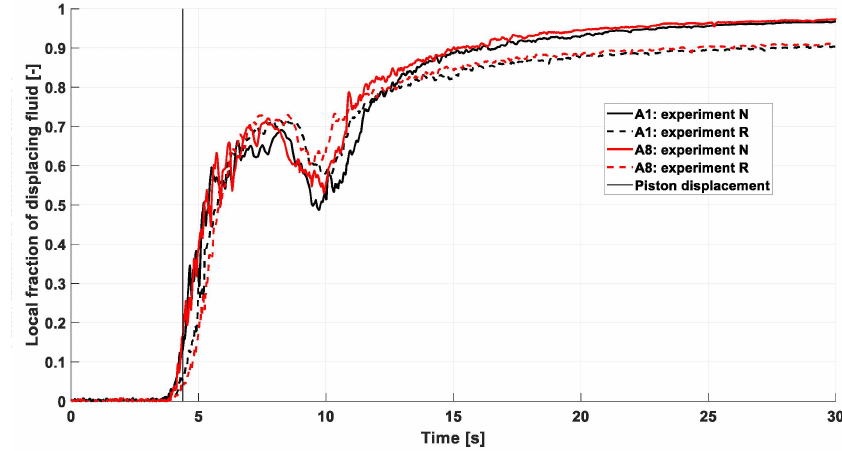
Figure 11. Local fraction of displacing fluid near the inlet (station A) and near the top (positions 1 and 8) for an experiment with inclined (60 degrees) concentric annulus (experiment N), and a repetition experiment (R), both without rotation of inner pipe.